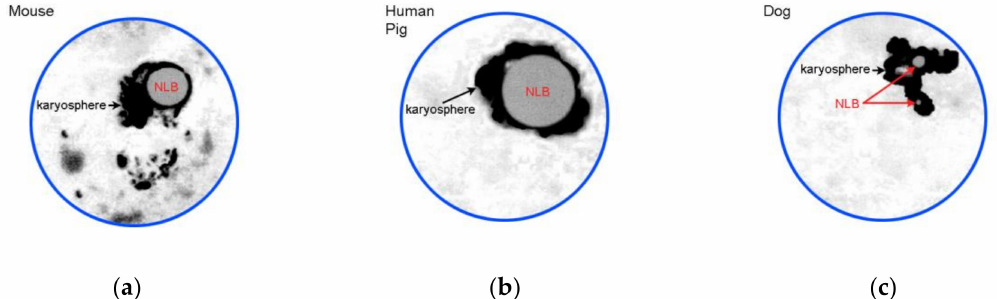
Figure 2. A cartoon illustrating most representative examples of SN chromatin configurations: ( a ) conspicuous nucleolus-like body (NLB) is rimmed by condensed chromatin forming a karyosphere, but some heterochromatin blocks are also located outside; ( b ) all the chromatin is assembled into a rather compact karyosphere around large NLB; and ( c ) configuration similar to (b), but NLBs are not so prominent. Designed according to Figure 1c and data from